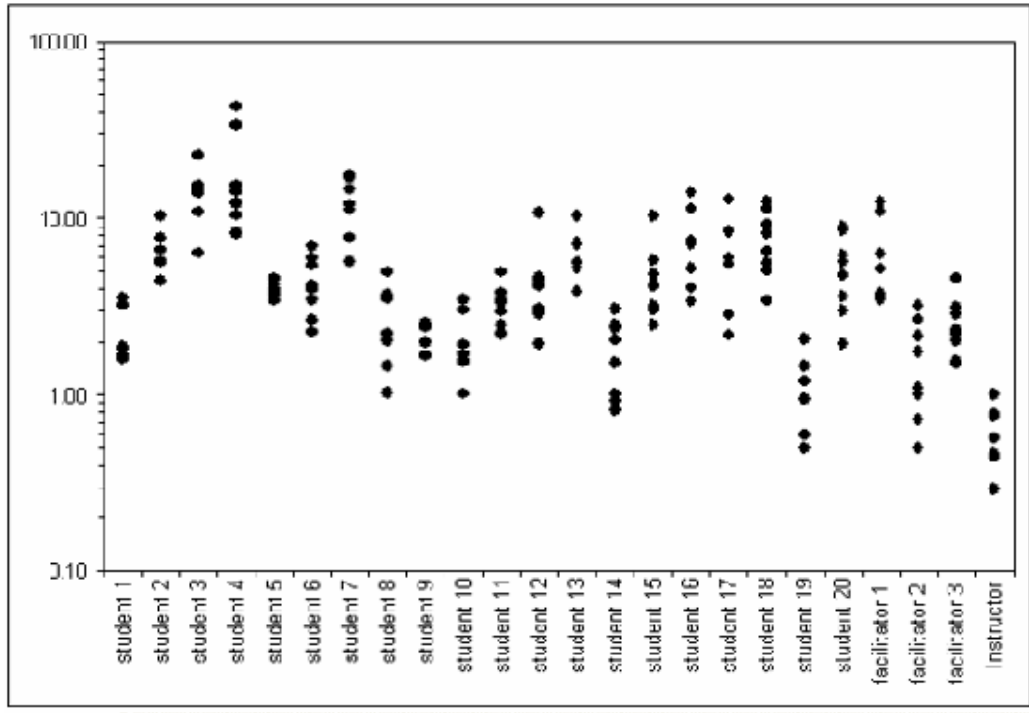
Figure 4. Ratio of Attending to Participating for each participant for each class session. Each data point represents one 3-hour